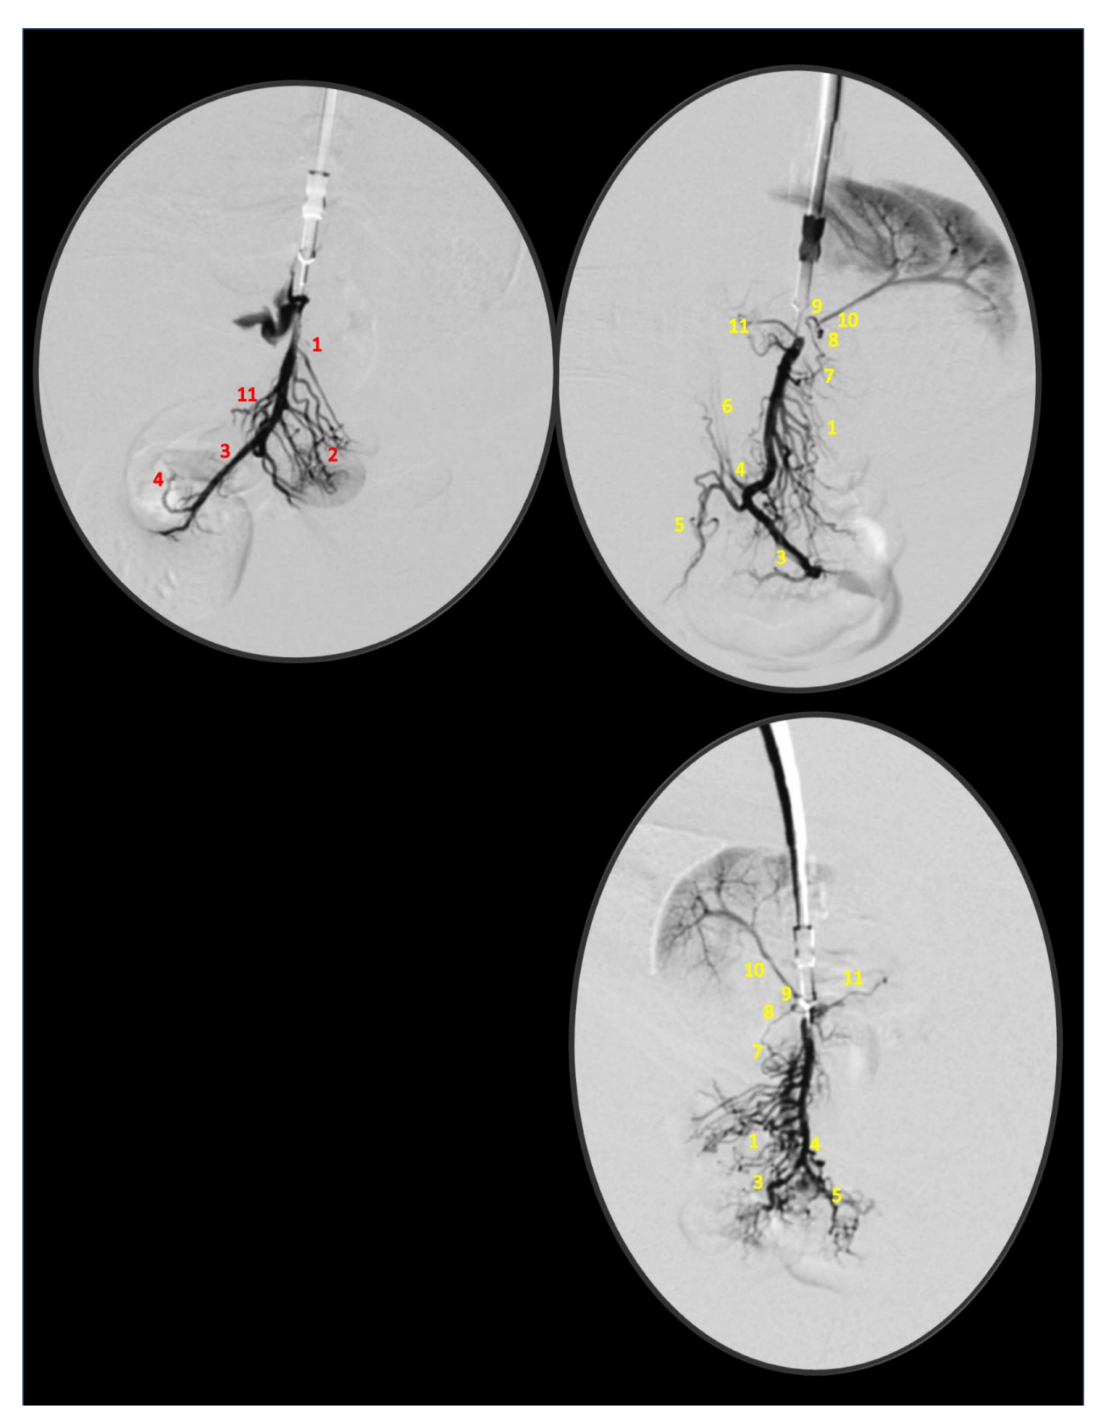
Figure 5. Superior mesenteric vein (below ligation) venography, and veins presentation (jejunal branches of superior mesenteric vein (1), ileal branches of superior mesenteric vein (2), superior mesenteric vein (3), ileocolic/right colic vein truncus (4), ileocolic vein (5), right colic vein (6), inferior anterior pancreaticoduodenal vein (7), superior anterior pancreaticoduodenal vein (8), pyloric vein (9), portal vein (10), middle colic vein (11)) in rats with the occlusion of the superior mesenteric vein and artery immediately following medication (BPC 157 10 µ g/kg (upper), or 10 ng/kg (low) (right) or saline 5 mL/kg (left)) given intraperitoneally at 15 min